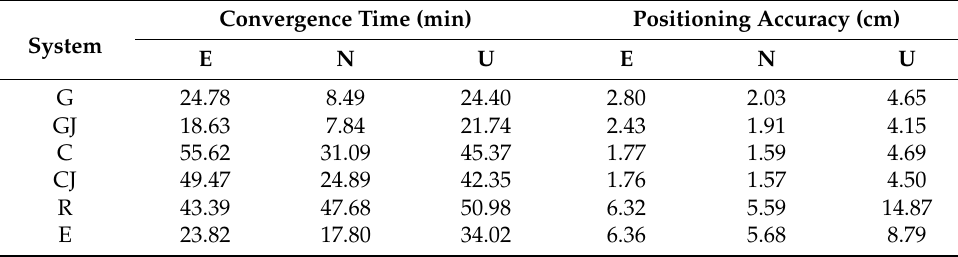
Table 7. Convergence time and positioning accuracy of different combination kinematic